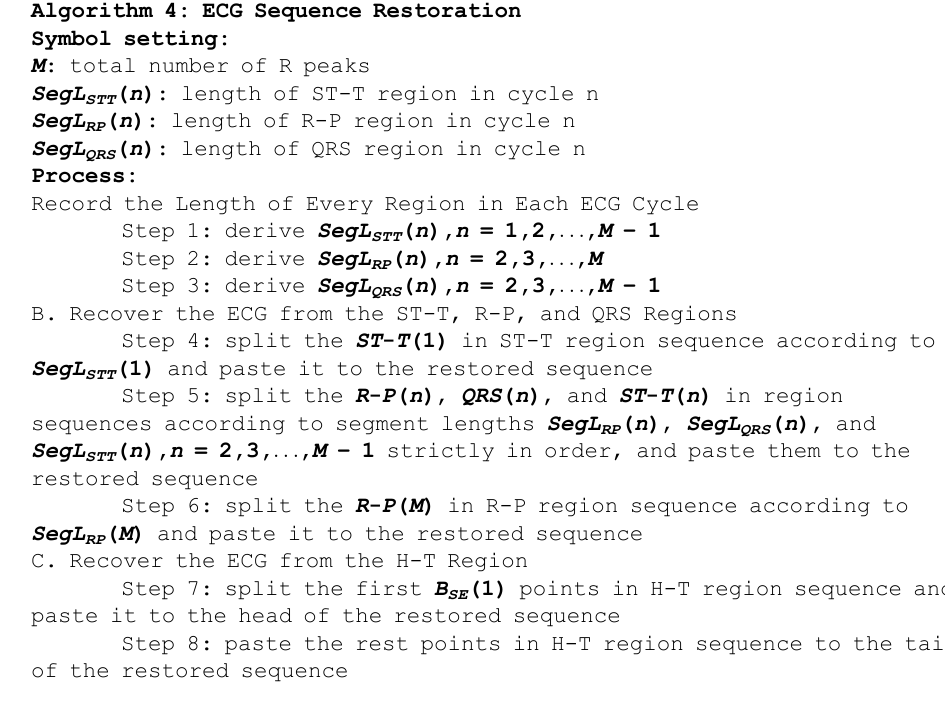
Algorithm 4: ECG Sequence